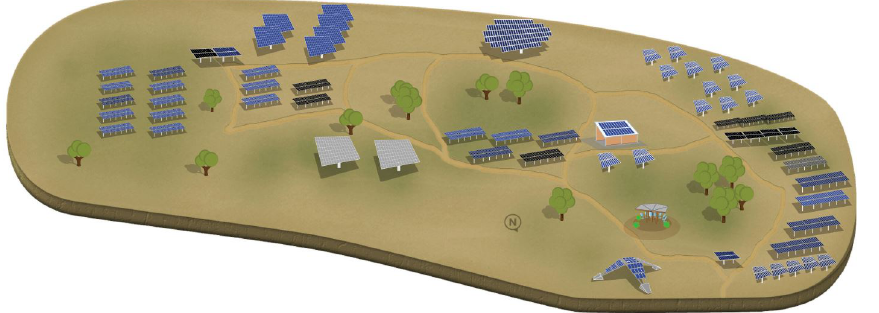
Figure 4. Representative chart of the DKASC PV plant [60].